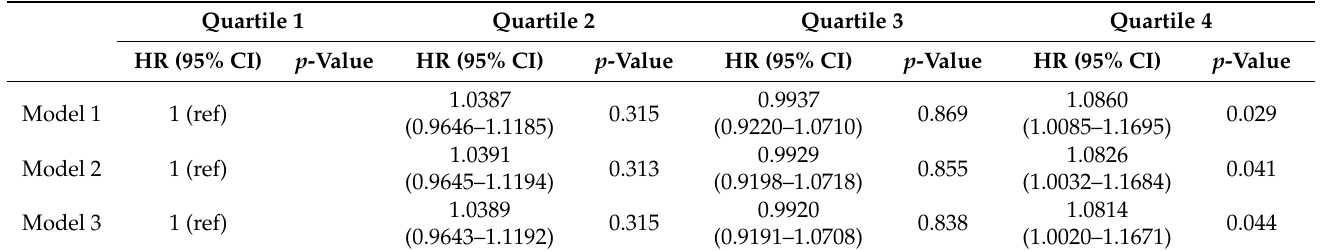
Table 4. Association of baseline high-sensitivity C-reactive protein (Hs-CRP) with incident cognitive impairment